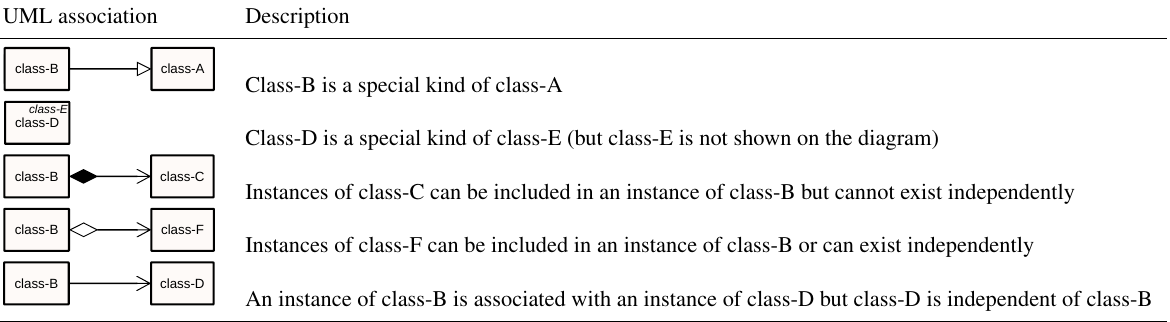
Table 1. The UML class associations used in this paper. See Fig. A1 for a worked